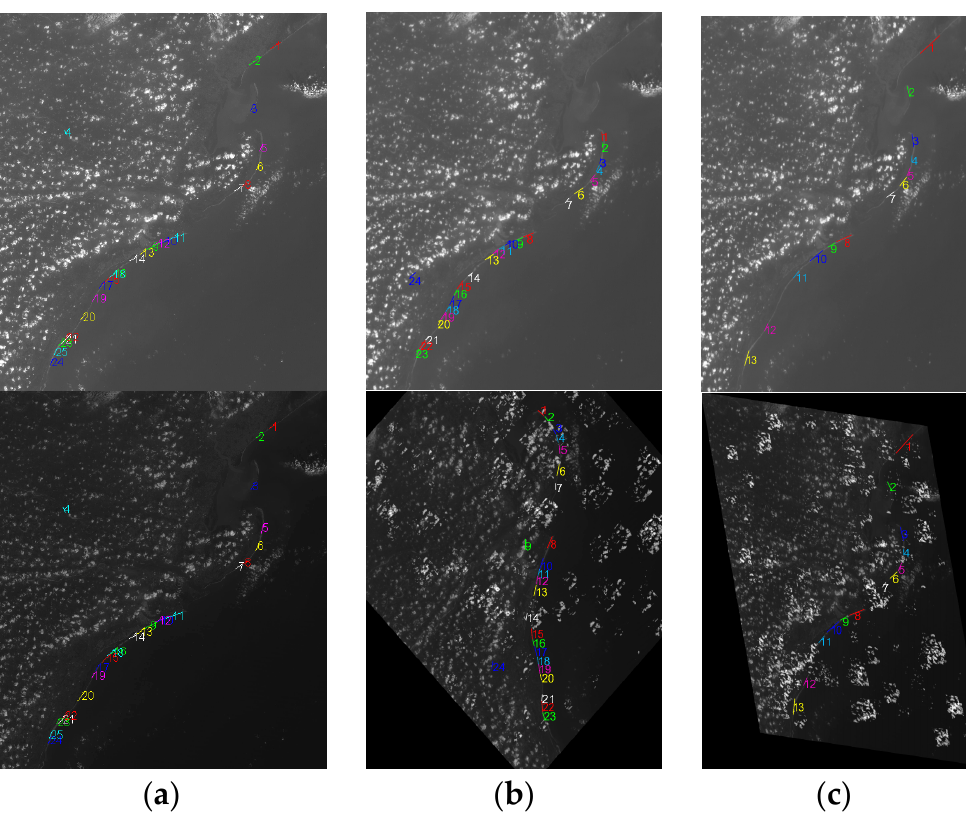
Figure 11. Matching results of the RMLSM on the simulated image pairs. ( a ) The first image pair in the first group; ( b ) the fourth image pair in the first group; ( c ) the fifth image pair in the first group.